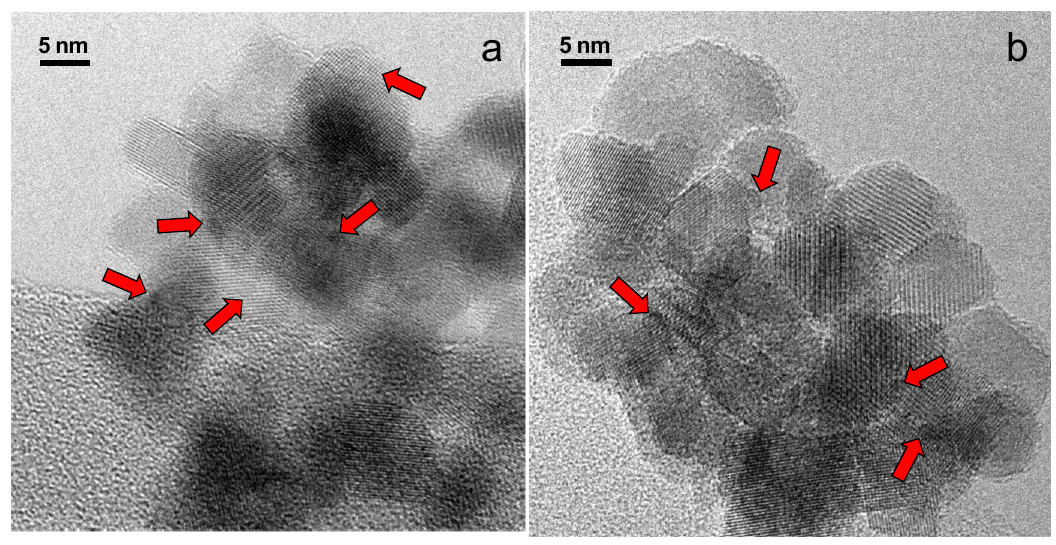
Figure 1. HRTEM representative images of calcined ( a ) and not calcined ( b ) 1AuSZ2 sample. Gold particles size distribution ( c ) obtained by HRTEM measurements performed on calcined (grey histogram) and not calcined (red histogram) 1AuSZ2 sample after 4 months. Both images have been taken at an original instrumental magnification of